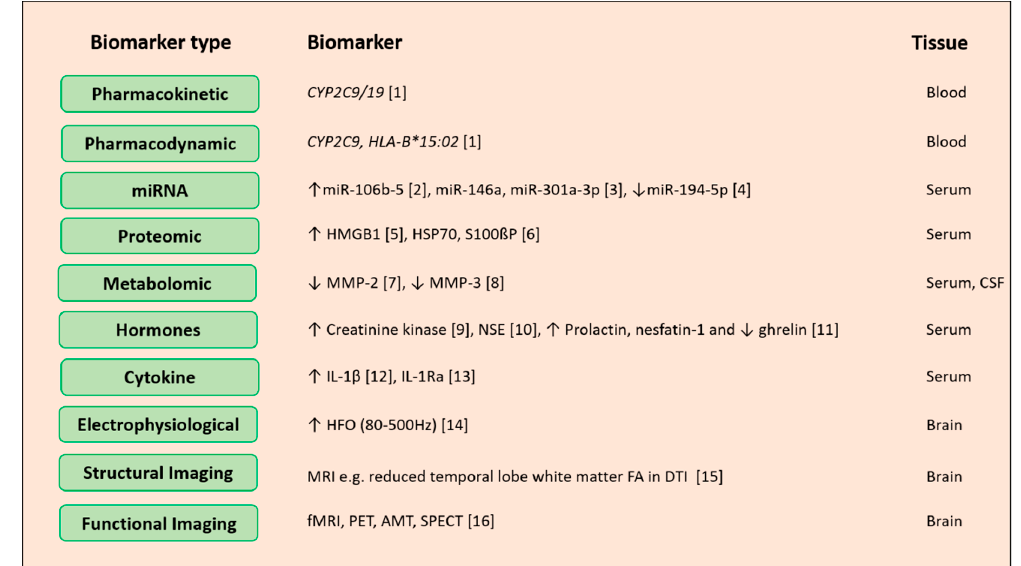
Figure 3. Potential biomarkers for epilepsy diagnosis. Biological levels and sources of epilepsy biomarker omics can be measured across different biological levels around the genome, pharmacogenome, transcriptome, proteome and metabolome. Other than these hormones, cytokines and electrical imaging records can also act as biomarkers for disease prediction, drug response improvement and avoidance of adverse side effects of drugs. Abbreviations: miRNA: microRNA, CYP2C9: cytochrome P450 family 2 subfamily C member 9, HLA-B: major histocompatibility complex class I, B, HMGB1: high mobility group box 1, HSP70: heat shock protein 70, S100ßP: S100 calcium-binding protein B, MMP: matrix metallopeptidase 2, NSE: neuron-specific enolase, IL-1 β : interleukin-1 beta, IL-1Ra: interleukin-1 receptor antagonist, HFO: high-frequency oscillations, MRI: magnetic resonance imaging, FA: fractional anisotropy, DTI: diffusion tensor imaging, fMRI: functional magnetic resonance imaging, PET: positron emission tomography, SPECT: single photon emission computed tomography.